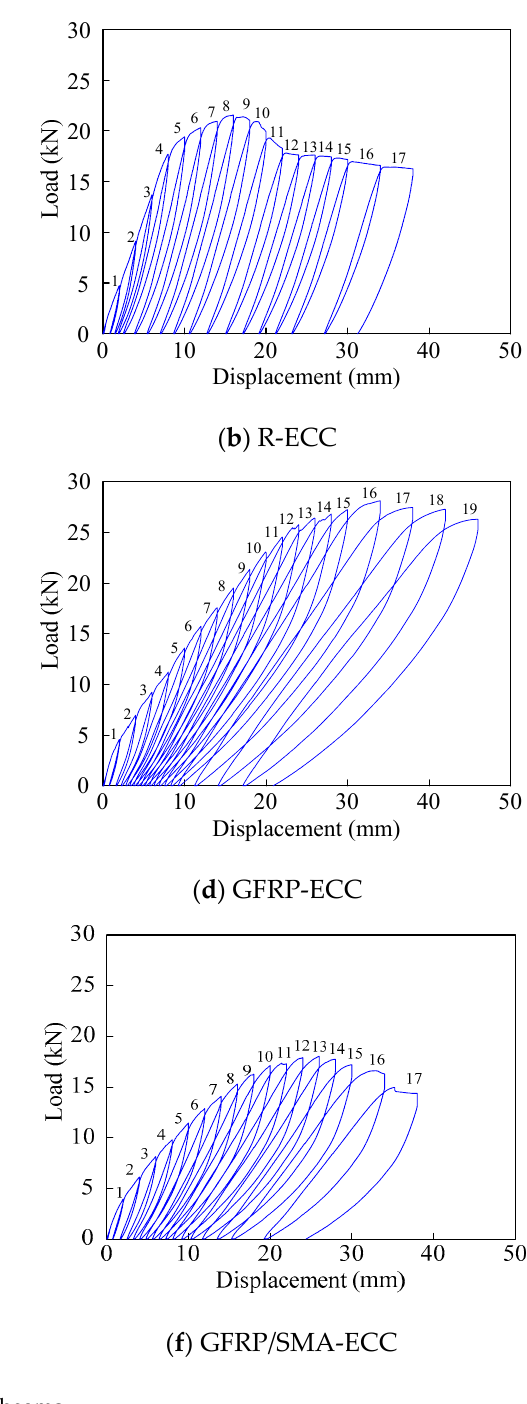
status. The increment of the damage index correlates with the increment of the loading step. Specifically, the damage index increases greatly with the application of the first-level loading, and the increment of beam RC is largest among all specimens. After the fifth-level loading, the values of damage index for six tested beams are very close to one, indicating extreme structural